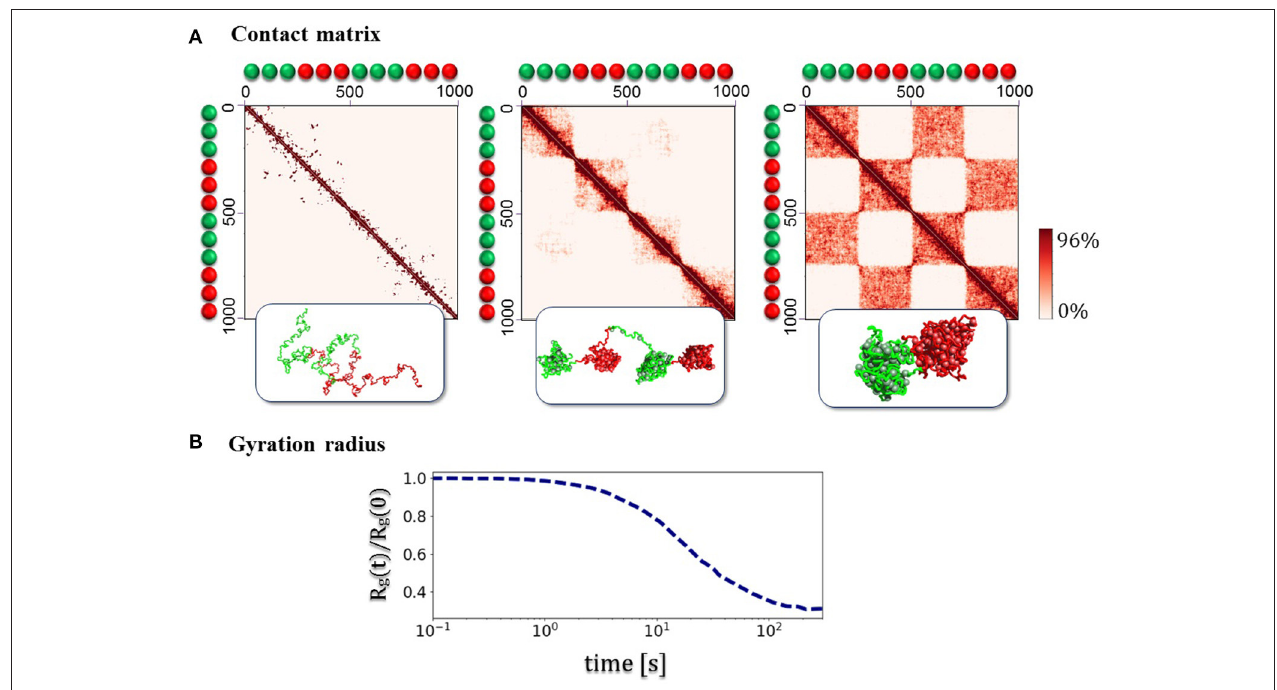
FIGURE 3 | Assembly of topological domains and higher-order structures. (A) The figures illustrates the folding dynamics of a block-copolymer toy model where only blocks of two different binding sites (green/red) are present, with blocks alternated along the polymer. The system spontaneously folds in a compact state where initially local separated domains (as the TADs in the Hi-C data, Dixon et al., 2012; Nora et al., 2012) are formed, and at equilibrium a hierarchy of higher-order domains appears (as the metaTADs in the Hi-C data, Fraser et al., 2015). (B) The folding dynamics of the system from an initial SAW conformation is marked by the decrease of the gyration radius Rg(t) as a function of time t . In the case shown here, each block equilibrates in the globular-disordered conformational class ( Chiariello et al.,